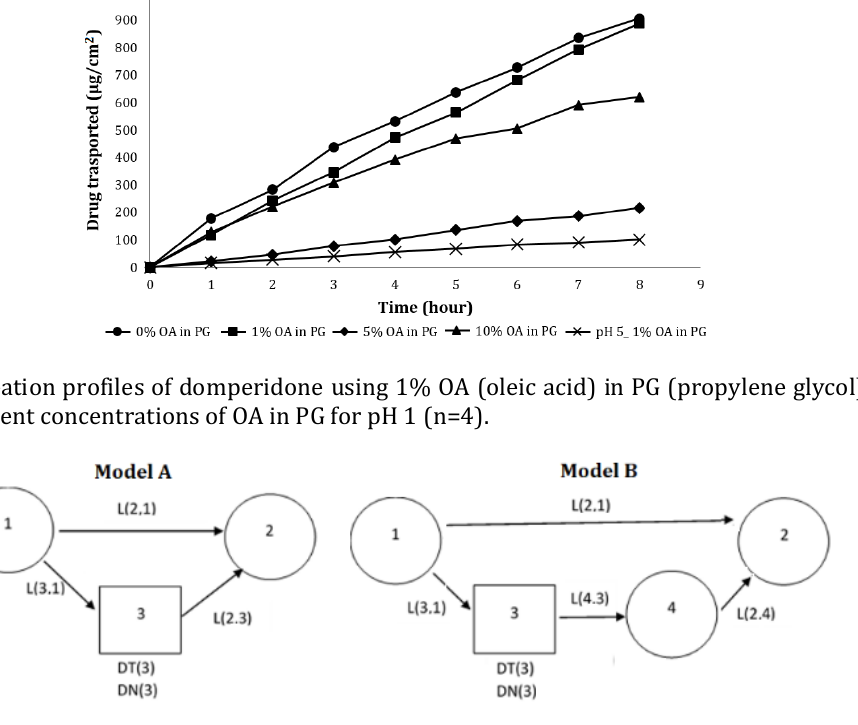
Figure 2. Schematic proposed models for transdermal transport of domperidone. Table I. AICc Parameters of proposed model A and B